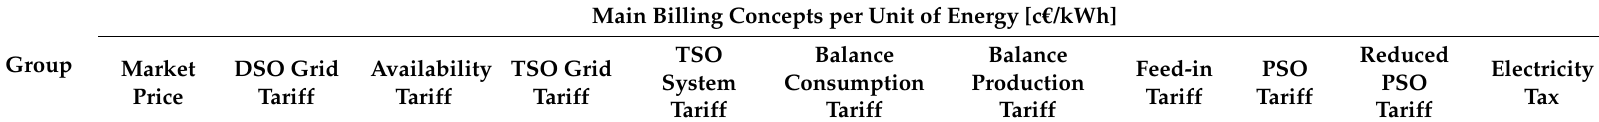
Table 3. Main billing concepts applied on the energy registered at the different metering points of PV net settled facilities. Self-elaboration.